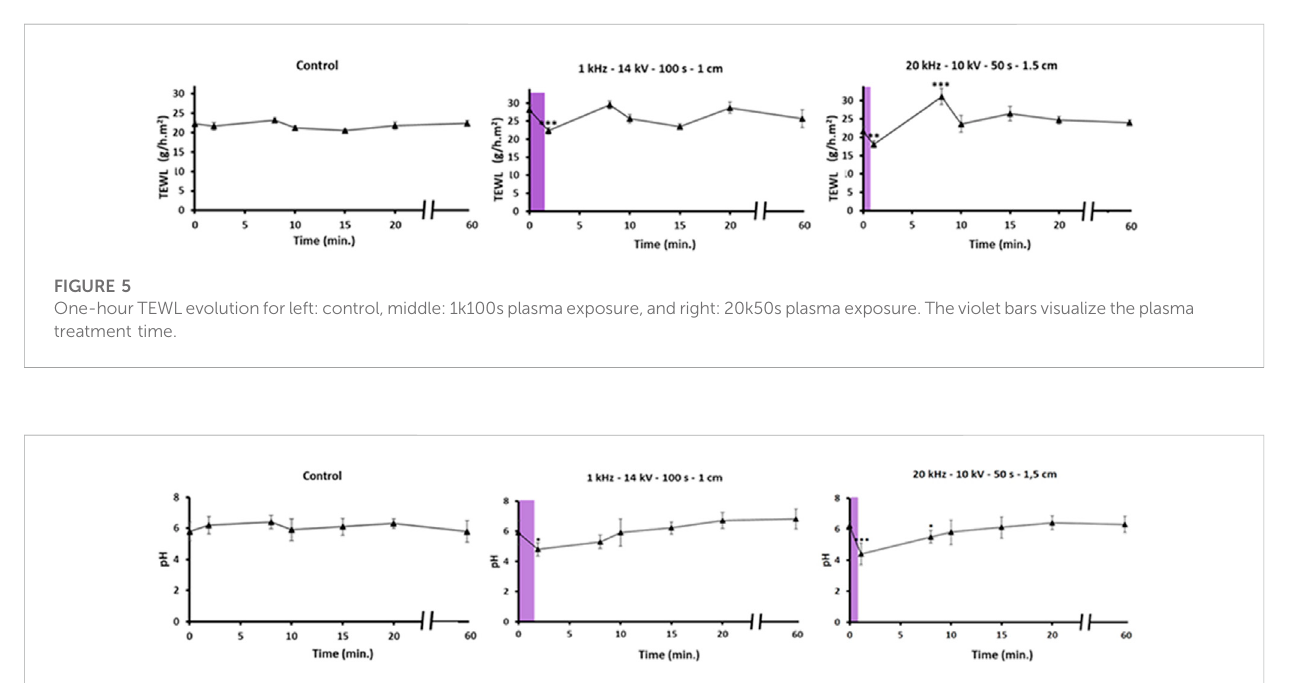
FIGURE 6 One-hour skin pH evolution for left: control, middle: 1k100s, and right: 20k50s exposures. The violet bars visualize the plasma treatment